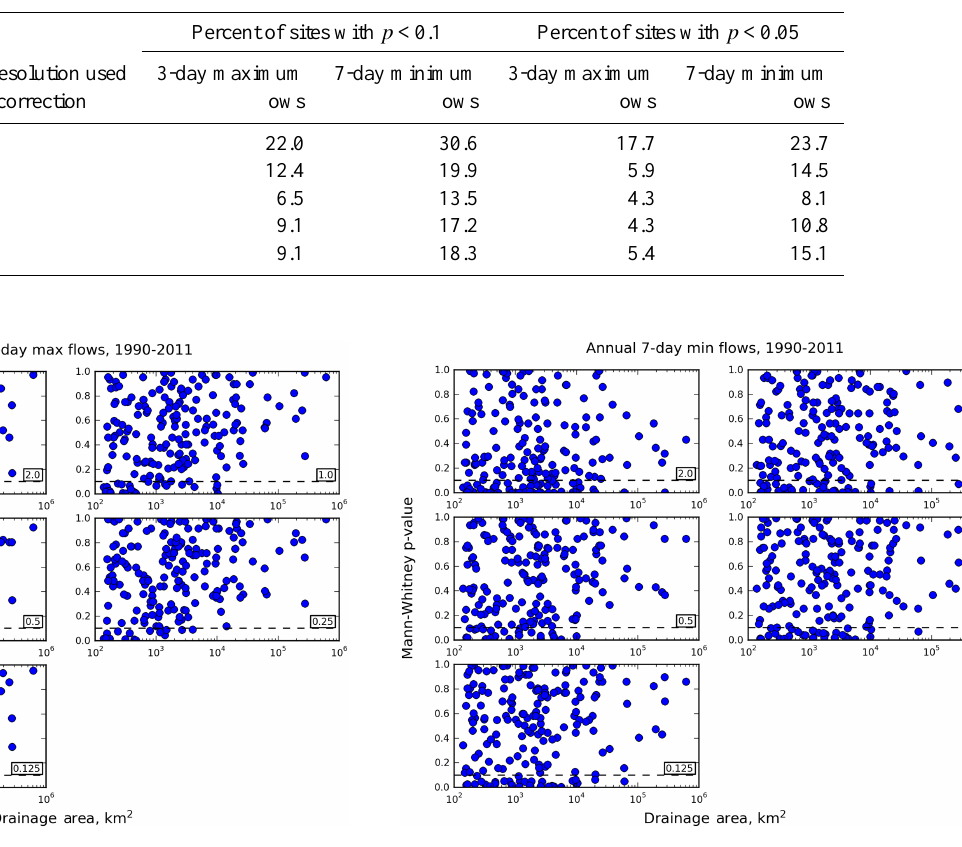
Figure 8. P values from the Mann–Whitney U test vs. the drainage area for each of the streamflow sites in Fig. 2. The dashed hori- zontal line at p = 0.1 is shown for reference; p values less than this are indicative of poor correspondence between observation- and reanalysis-driven streamflows.